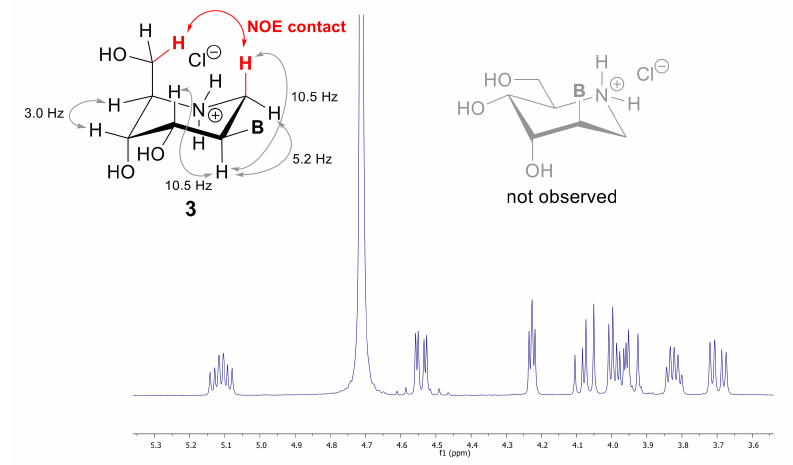
Figure 3. 1 H NMR analysis of 3